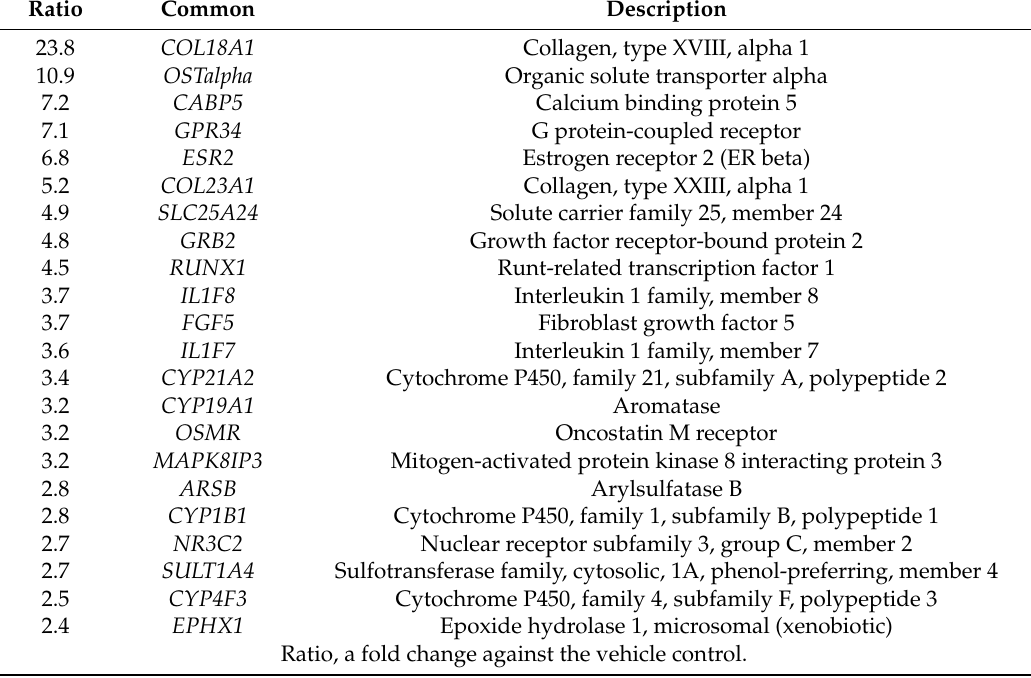
Table 1. Gene expression induced by 3-methylcholanthrene treatment in